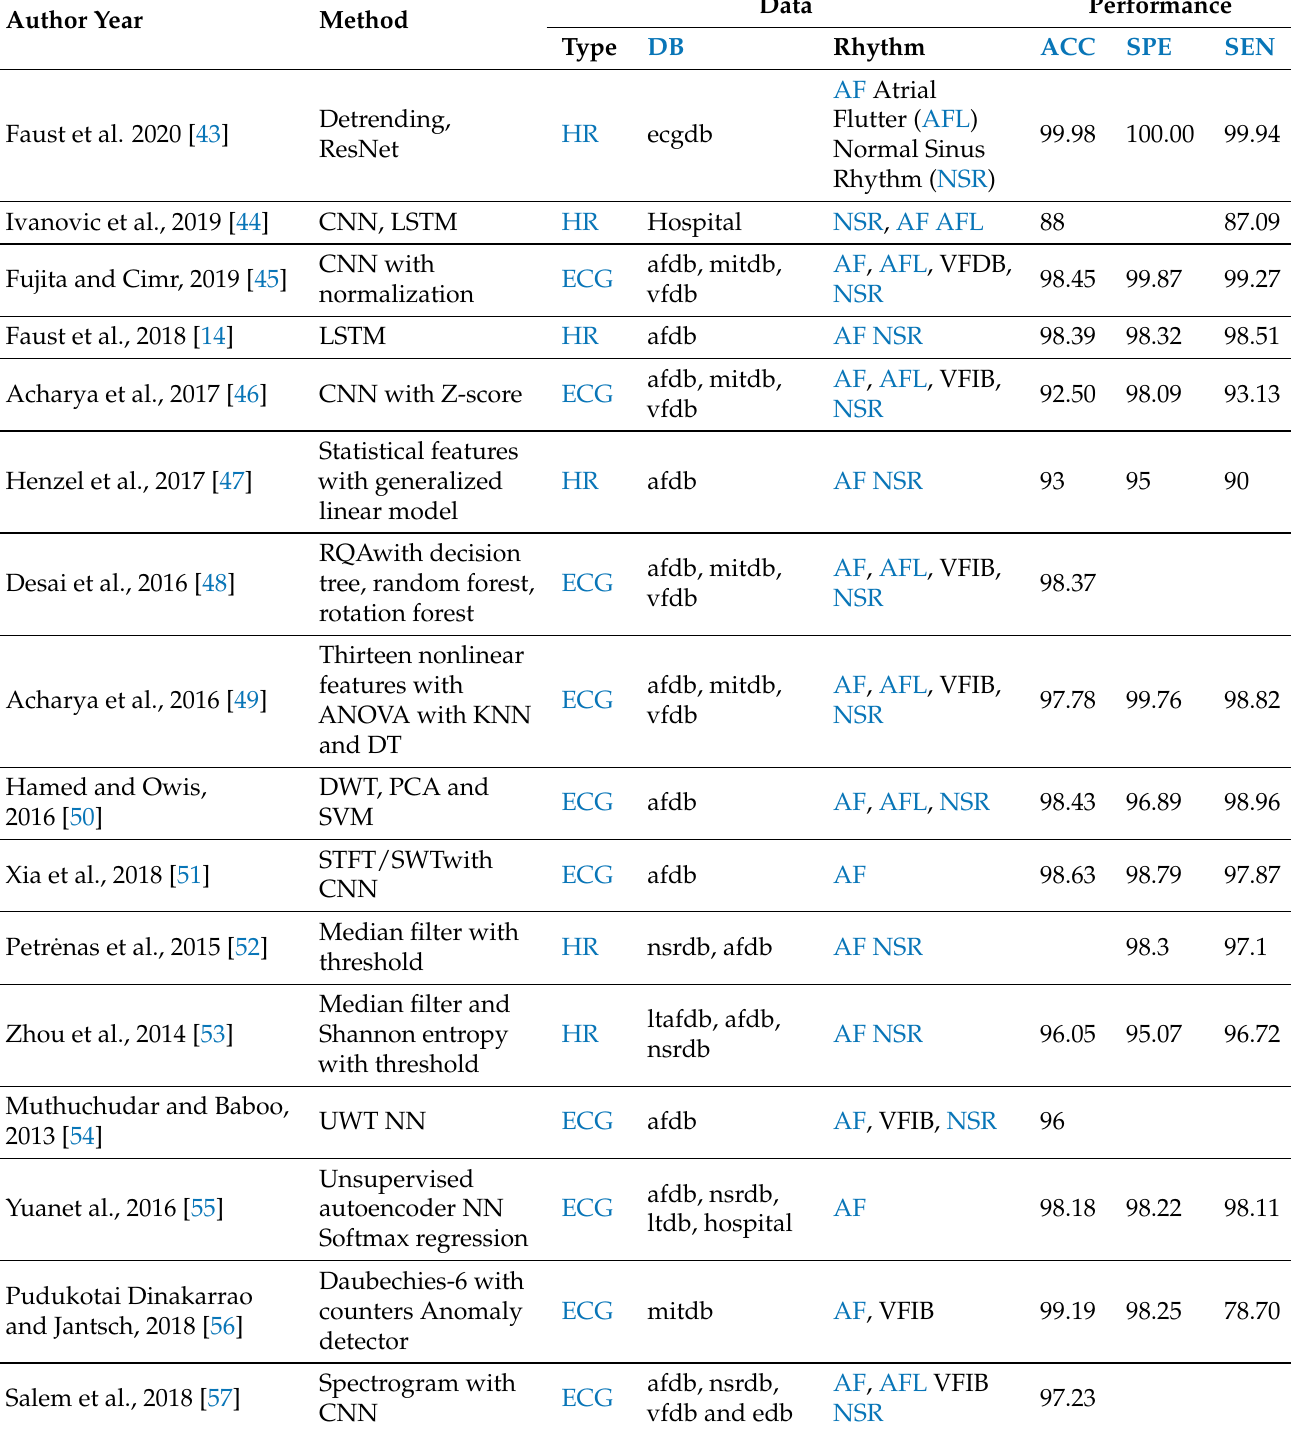
Table 3. Selected arrhythmia detection studies using HR and ECG. Database (DB) were: MIT-BIH Atrial Fibrillation Database (afdb), MIT-BIH Arrhythmia Database (mitdb), MIT-BIH Malignant Ventricular Arrhythmia Database (vfdb), Creighton University Ventricular Tachyarrhythmia Database (cudb), MIT-BIH Normal Sinus Rhythm Database (nsrdb), MIT-BIH Long Term